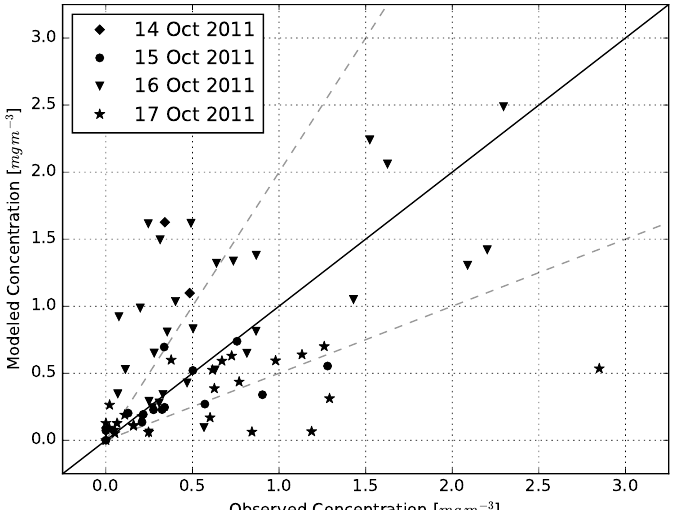
Figure 14. Time series of emission flux at 41.31° S, 69.72° W during the August outbreak (solid red line). The typical diurnal variability associated with resuspension events can be recognised except for 28 August, when an sharp increase in soil moisture (solid black line) due to rainfall (dashed line) prevented ash emission during the afternoon.